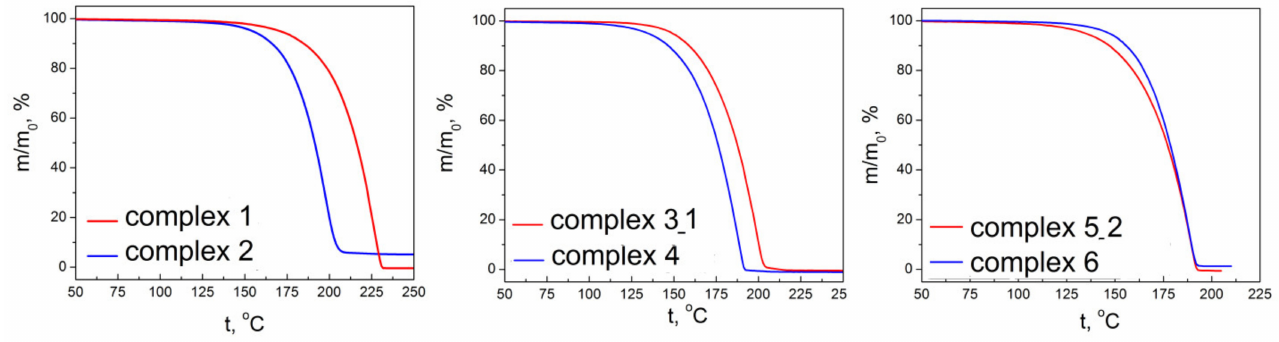
Figure 9. TG curves of complexes 1 – 6